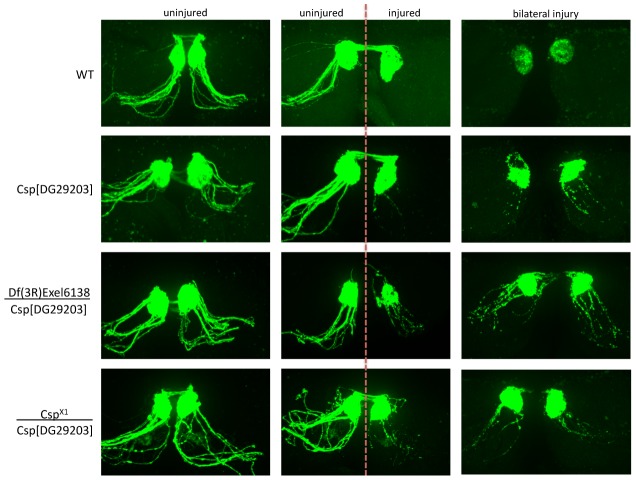
Detailed genetic analysis confirms DNAJC5/CSP as a robust regulator of axo-synaptic degeneration in vivo.
Representative confocal micrographs showing axon degeneration profiles in wild-type (WT) flies and additional DNAJC5/CSP lines: cspX1, a loss of function allele which deletes the first exon of csp; and Df(3R)Exel6138, a deletion which completely removes the csp locus. Examples are shown of uninjured axons (left panels), unilaterally injured axons (middle panels) and bilaterally injured axons (right panels). Both cspX1 and Df(3R)Exel6138 failed to complement the delay in axonal degeneration observed with our original allele (cspDG29203), thereby mapping this phenotype to the csp locus. Note how the severity of the delay in axonal degeneration was enhanced when cspDG29203 was placed over either of these null alleles of csp, suggesting that cspDG29203 is a weak loss of function allele.